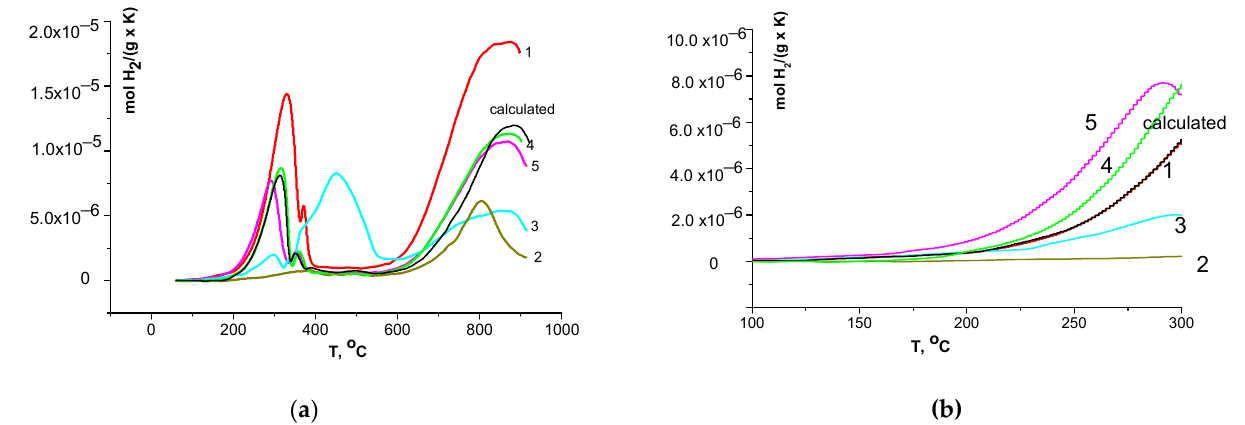
Figure 5. H 2 -TPR data ( a ) and low temperature consumption ( b ) for samples. Curves designations correspond to sample numbers (Table 1). Calculated (black line)—he calculated data for the mixture LaFe 0.4 Ni 0.6 O 3 + CeO 2 in a 1:1 ratio. Table 4. H 2 -TPR data.